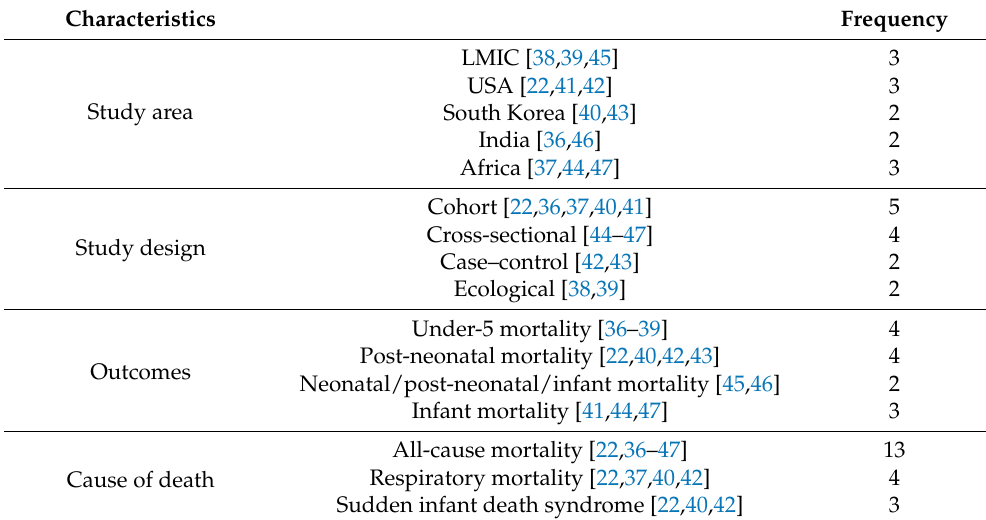
Table 2. Summary of study designs and